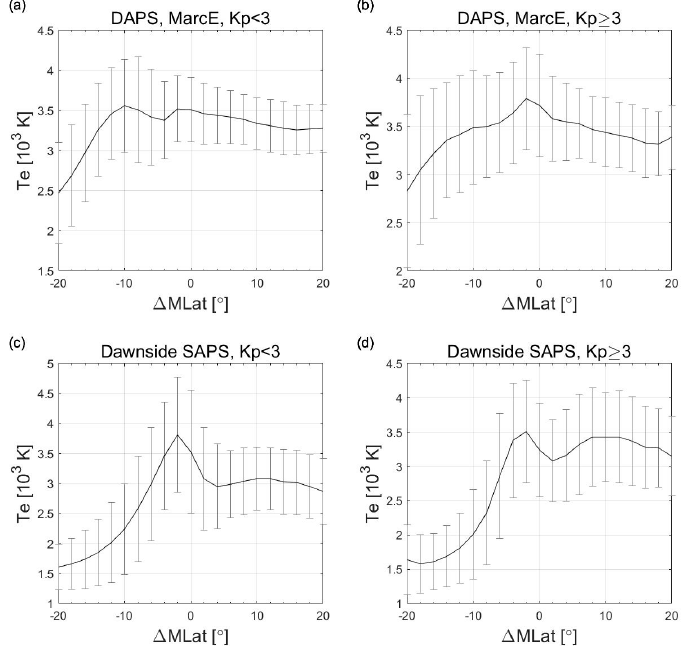
Figure 10. Superposed epoch analyses of the electron temperature for DAPS ( a , b ) at March equinox and dawnside SAPS events ( c , d ) without seasonal separation under different geomagnetic activity levels. The 0 key MLat denotes the latitude where the cross-track velocity peaks. The bars show the mean standard deviations of 2° averages.